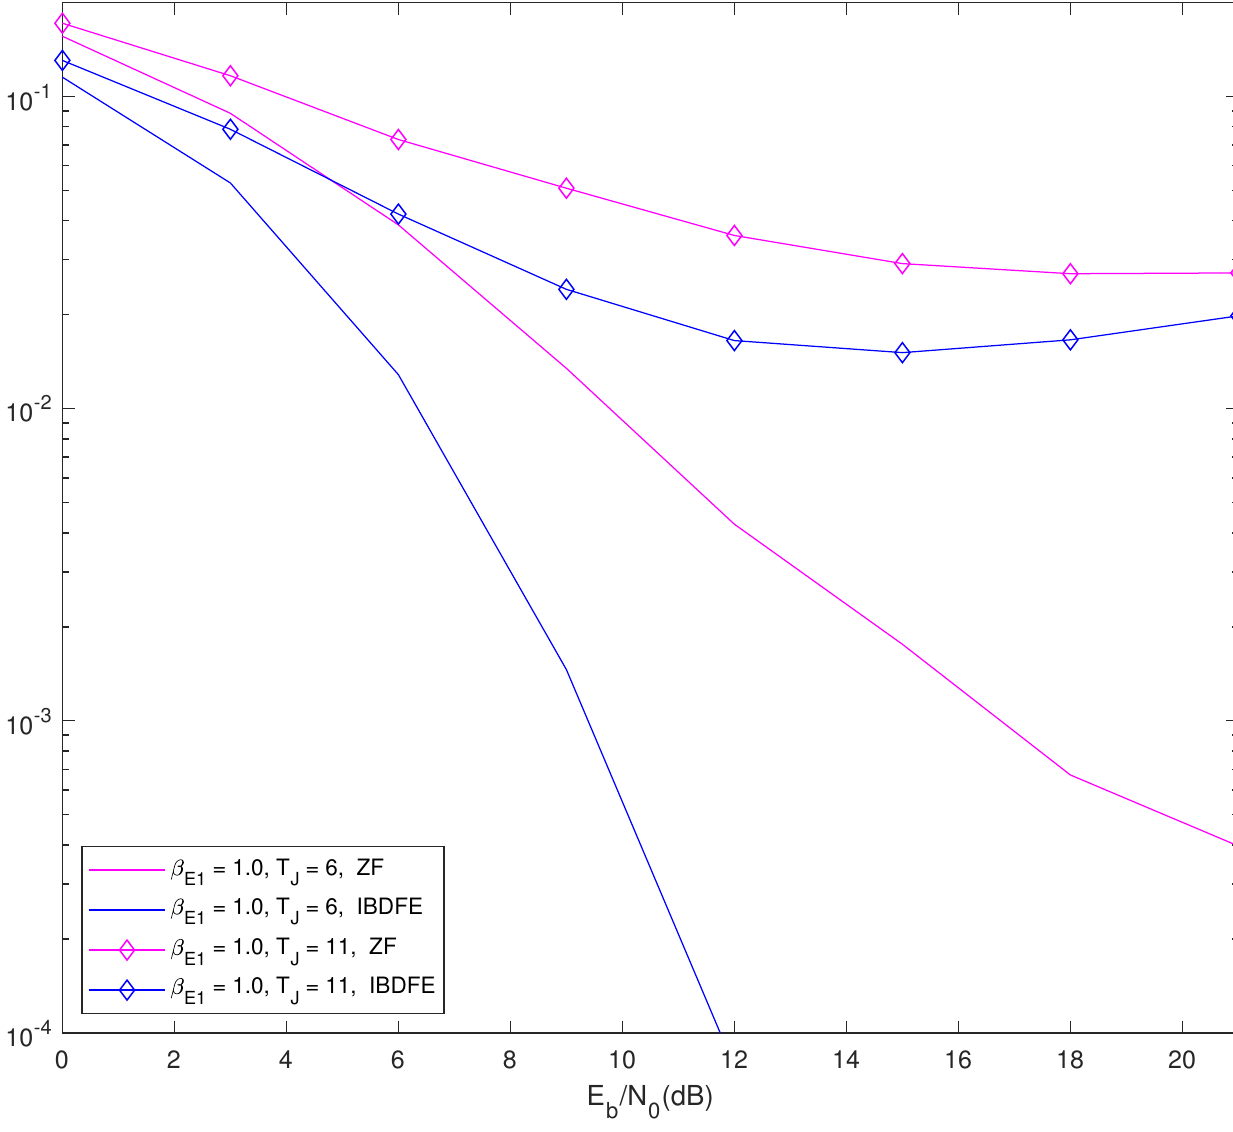
Figure 7. The performance of IBDFE versus ZF at E1, where the feedback of jamming signal estimate is included to reduce